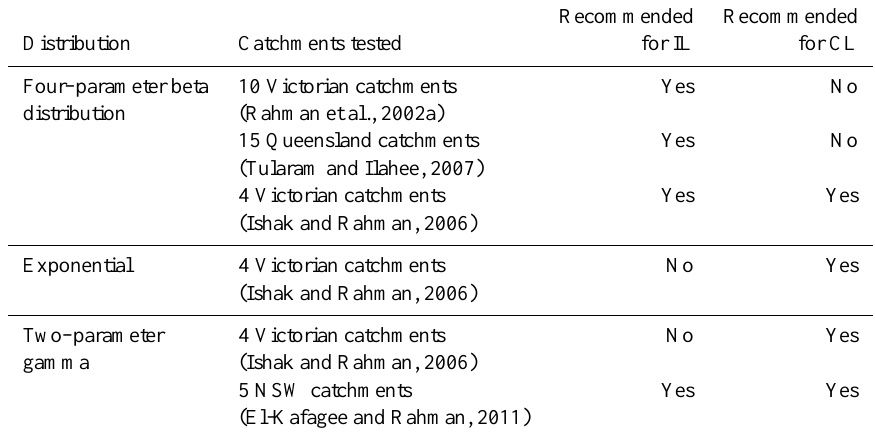
Table 1. Distributions tested for Australian